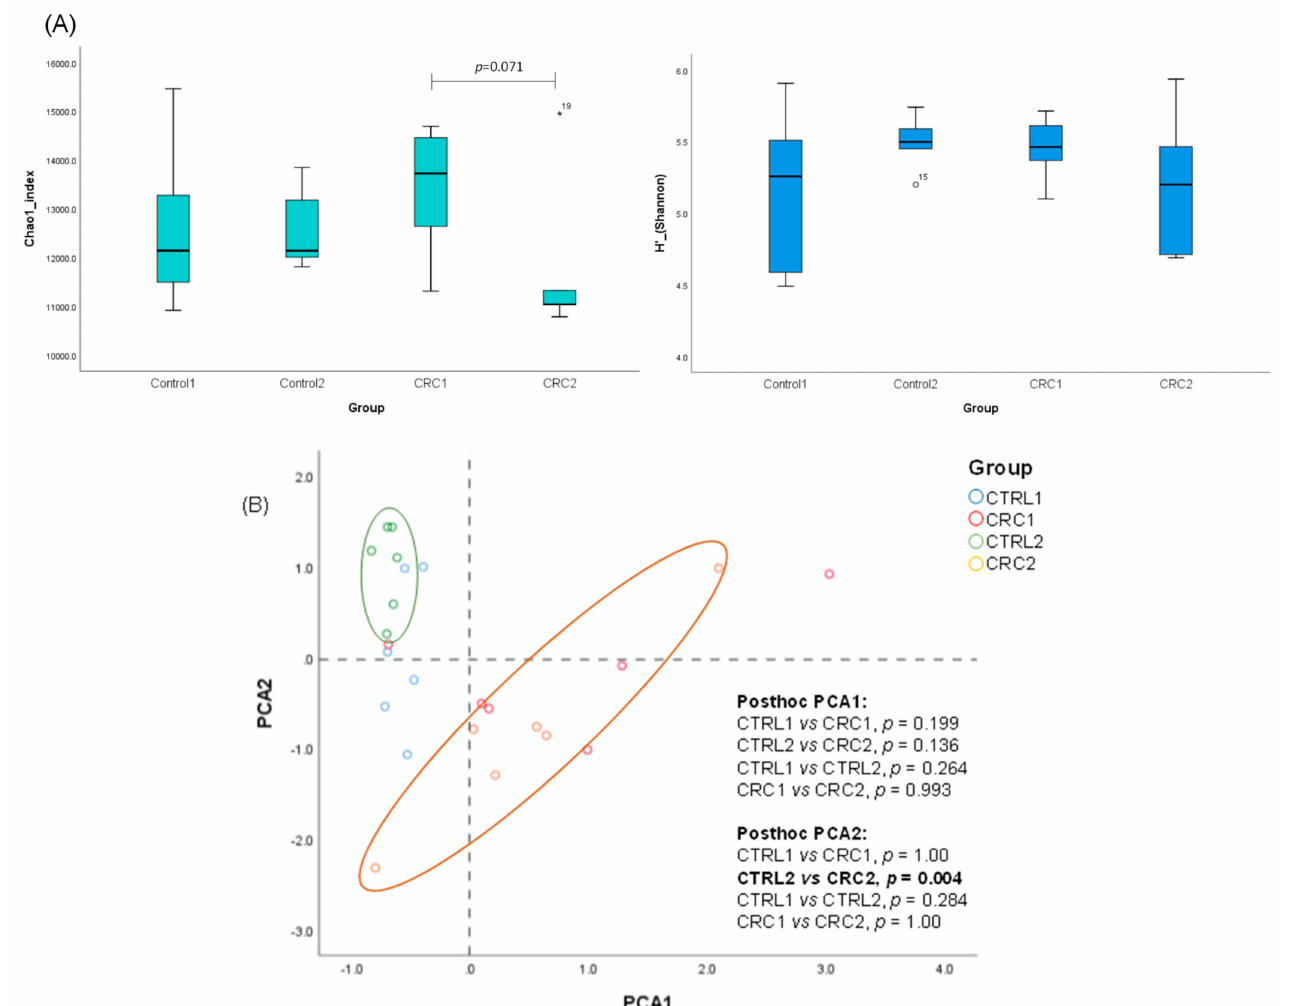
Figure 7. ( A ) Alpha diversity comparisons of fecal microbiomes collected from the different CTRL and CRC groups. ( B ) PCA and clustering analysis showing differences between CTRL and CRC